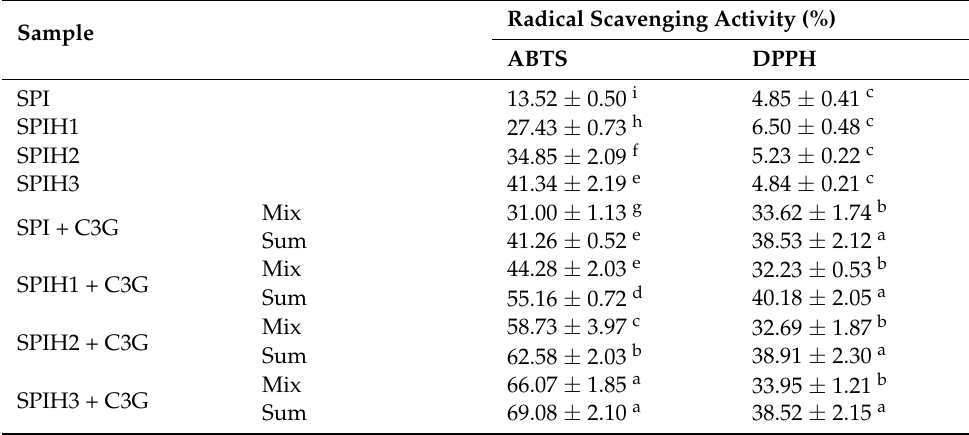
Table 4. ABTS and DPPH radical scavenging activities (%) of 1 mg/mL SPI/SPIHs with or without 0.04 mg/mL